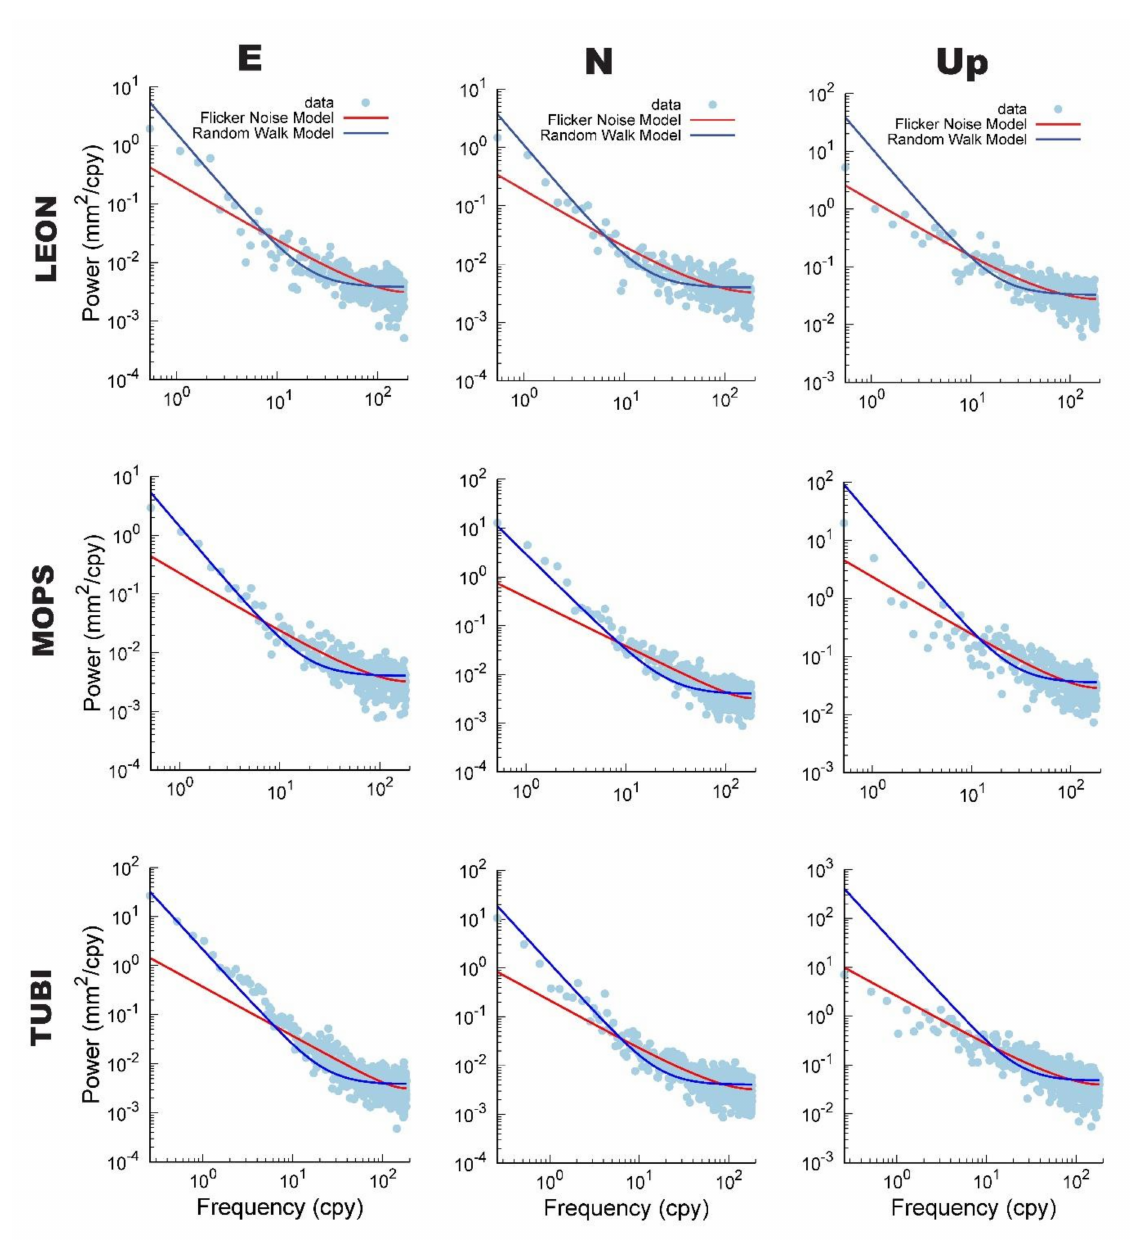
Figure 2. Power spectra density (PSD) for the East (E), North (N) and Up component for the three stations that experienced a dominant random walk noise model in the horizontal